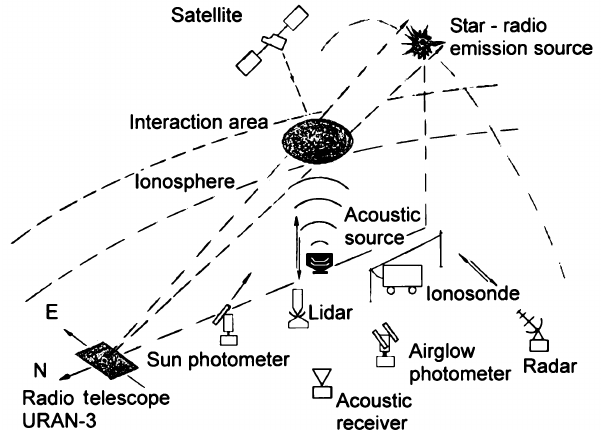
Figure 10. Acoustic active experiment proposed for verification of the model and mechanisms of the influence of the acoustic sound- ings on the ionosphere. Acoustic generator ( Acoustic source ) will operate at two close frequencies to produce impact at the Interac- tion area in the ionosphere. The comprehensive set of ground-based and satellite detectors, which includes an ionosonde, atmospheric li- dar, radio telescope URAN-3, airglow photometer, and aerosol sun photometer, will register background conditions and expected iono- spheric disturbances produced by the acoustic